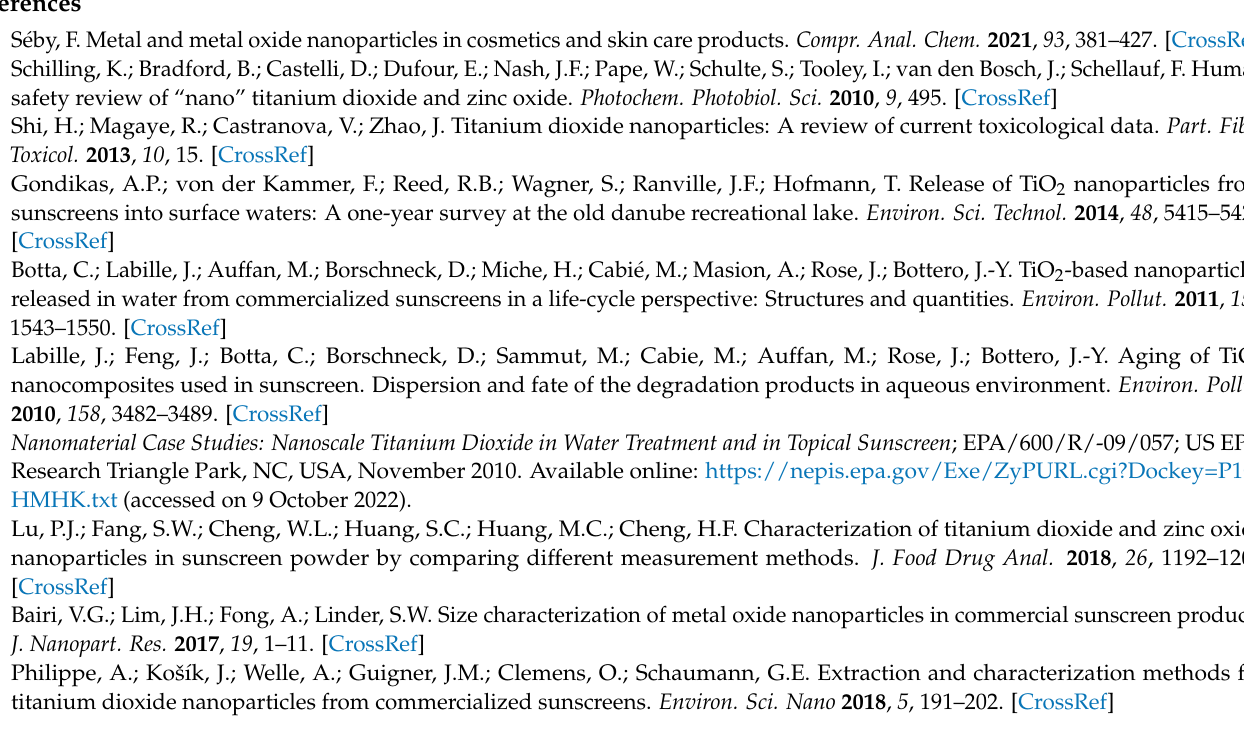
Table S3: The change in the background signal (LOD) and the number of TiO 2 NPs calculated by the SPCal software at the dwell time in the range of 1–20 ms; Table S4: Tested samples of cosmetic products; Figure S1: Changes in (a) the mean background intensity, (b) position of the distribution maximum on the intensity axis, (c) width of the oscillation range, and (d) standard deviation of the background signal intensity in the dwell time range of 0.1–20 ms; Figure S2: Particle size distributions (hydrodynamic diameter) for cosmetic product samples (a) 3, (b) 4, and (c) 5 (IG-1000 nanoparticle size analyzer (Shimadzu, Japan), voltage–35 Vpp, frequency–500 kHz, time–0.10 sec); Figure S3: TiO 2 NP signal distributions in sample 3 at dwell times of (a) 1, (b) 4, (c) 10, and (d) 16 ms using SPCal software; Figure S4: TiO 2 NP size distribution before and after background signal correction at dwell times (1) 4, (2) 10, (3) 16, and (4) 20 ms in samples (a) 3, (b) 4, (c) 5, and 6 (d, control); Figure S5: TiO 2 NP size distribution of sample 3 after background signal correction under optimized conditions at dwell times of (a) 4, (b) 10, (c) 16, and (d) 20